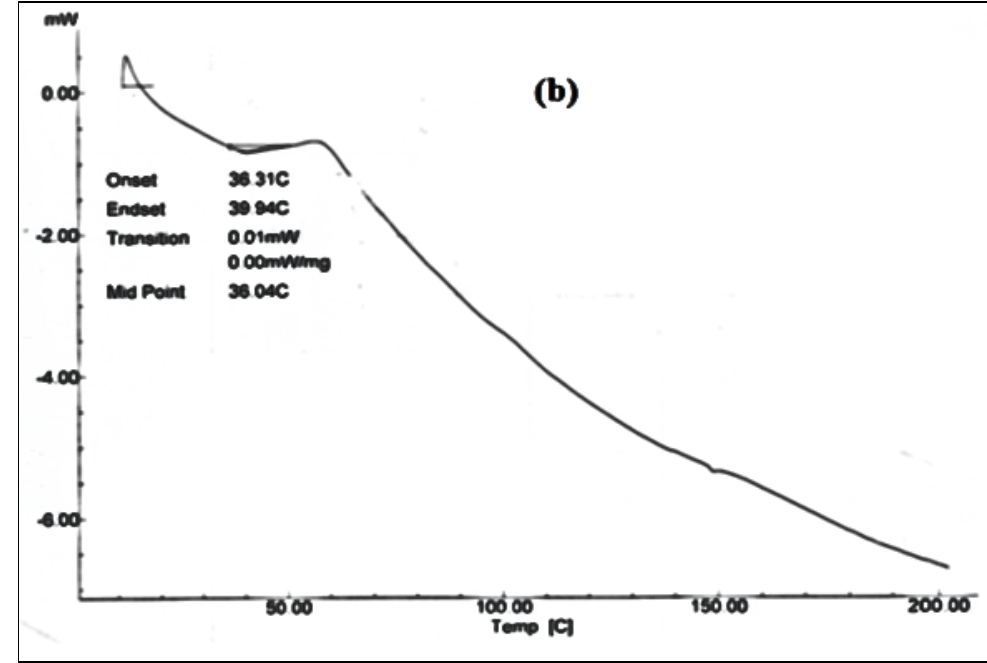
Fig.19: (Temperature glass transition) curves for composites (unsaturated polyester resin with filler (2%).